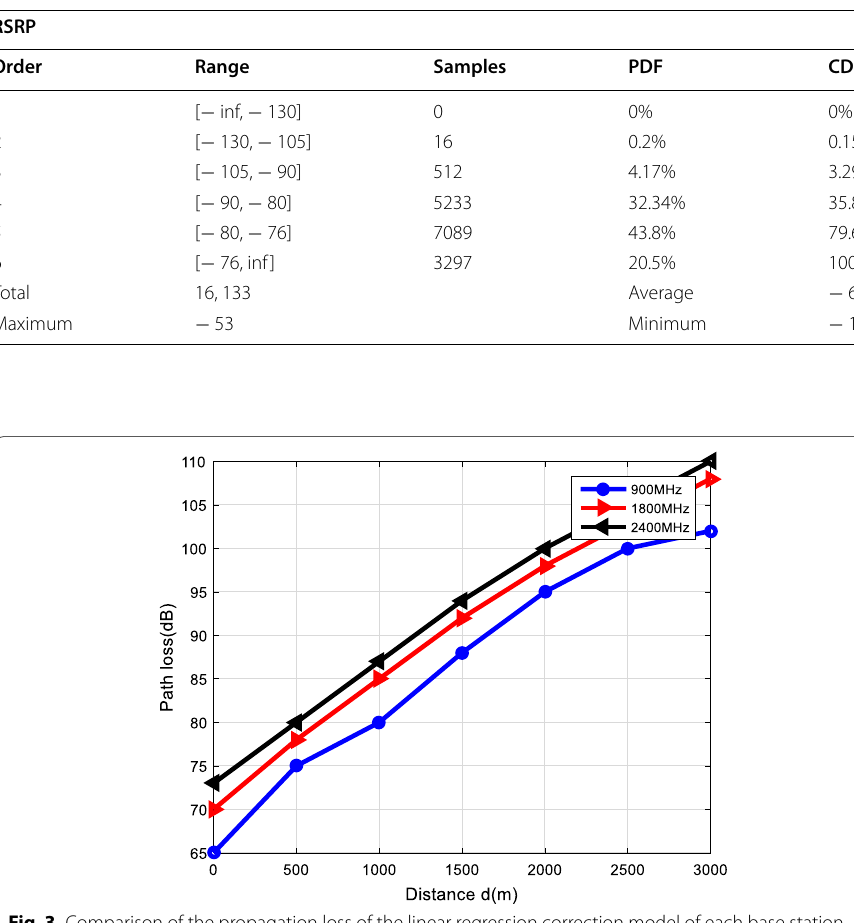
Table 5 RSRP level signal segment statistics